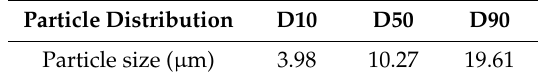
Table 2. Particle size distribution of 316L stainless steel